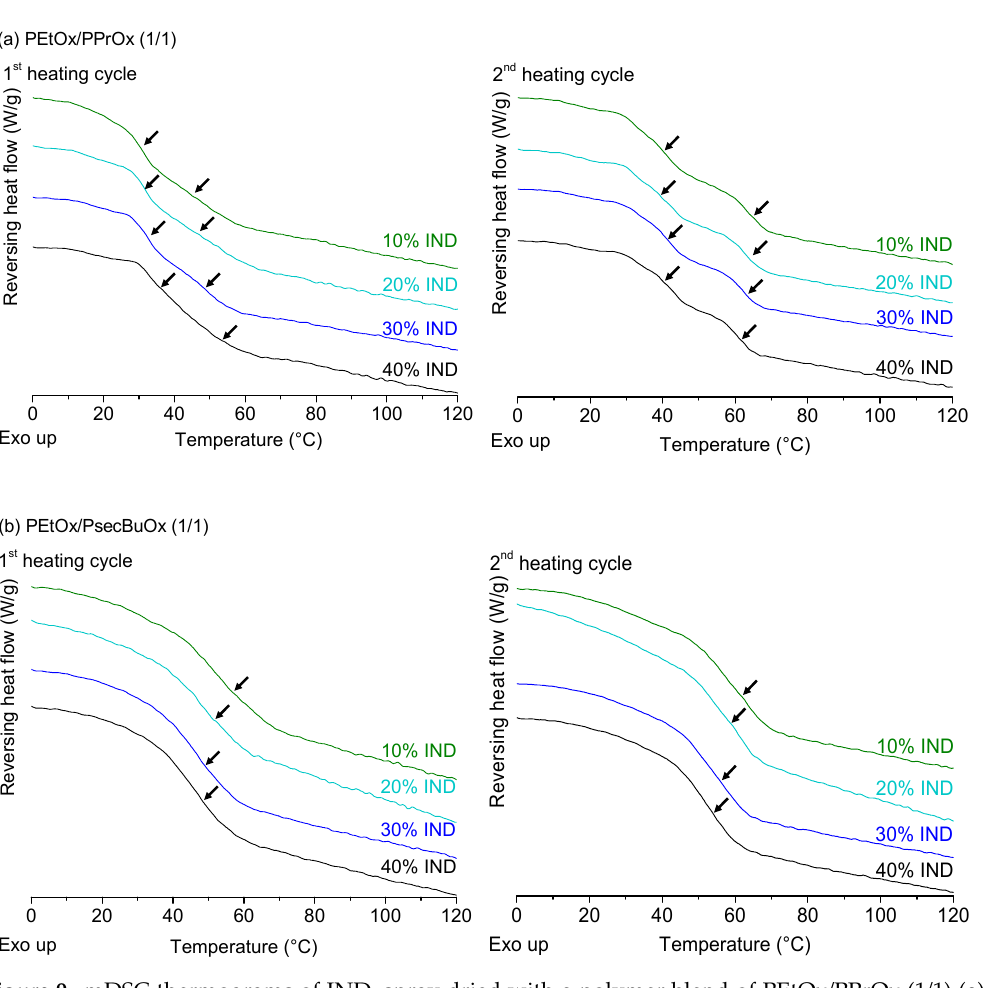
Figure 9. mDSC thermograms of IND, spray dried with a polymer blend of PEtOx / PPrOx (1 / 1) ( a ) and of PEtOx / PsecBuOx (1 / 1) ( b ). ASDs with four di ff erent drug loadings were prepared. Glass transitions are indicated with arrows in both first (left) and second heating cycle (right). Average T g values ( n = 3) can be found in Supplementary Materials S5a. Created with Origin 8.5 from OriginLab (Northampton, MA,